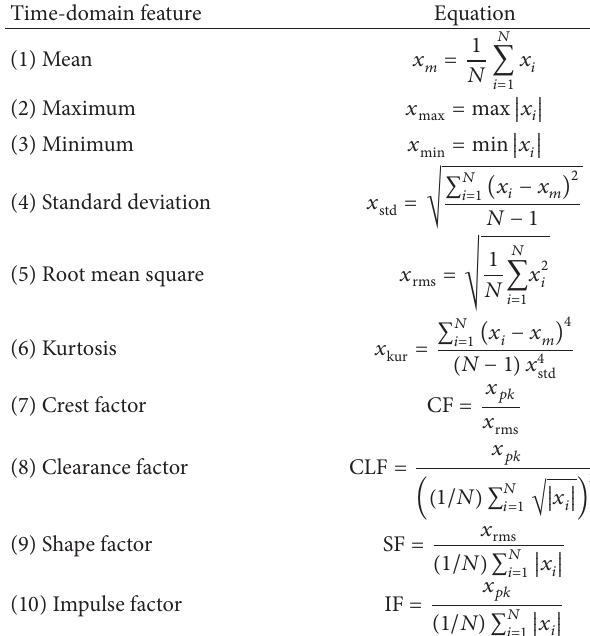
Table 3: Definition of common statistical features in